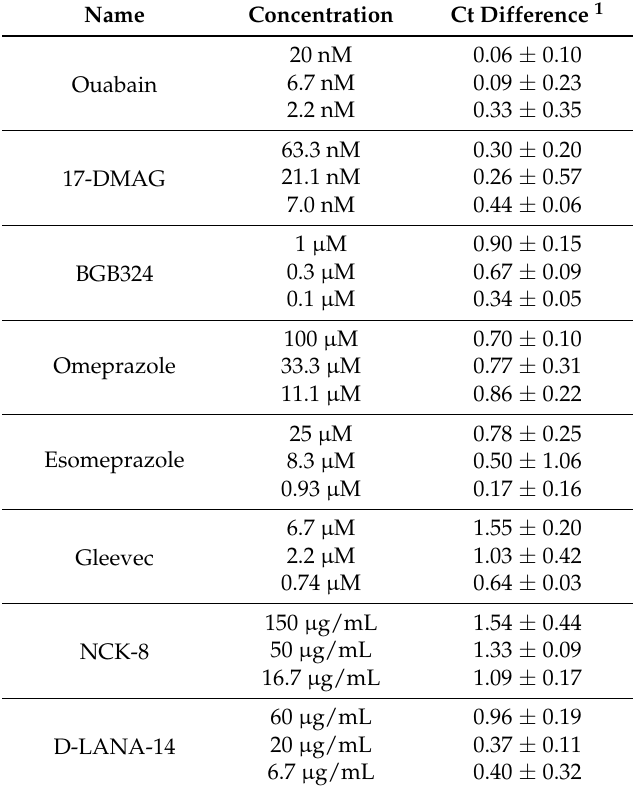
Table 3. Changes in EBOV RNA levels in MRC-5 cells treated with compounds at three dilutions determined not to cause cytotoxicity in non-infected treated